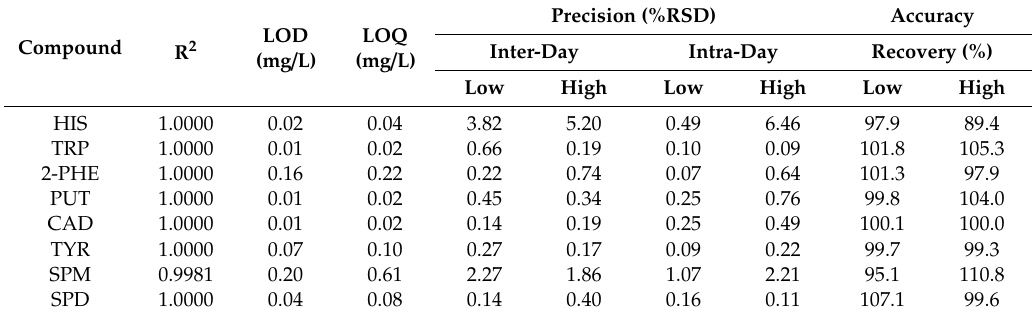
Table 1. Summary results relating to validation of the high-performance liquid chromatography (HPLC) method used for biogenic